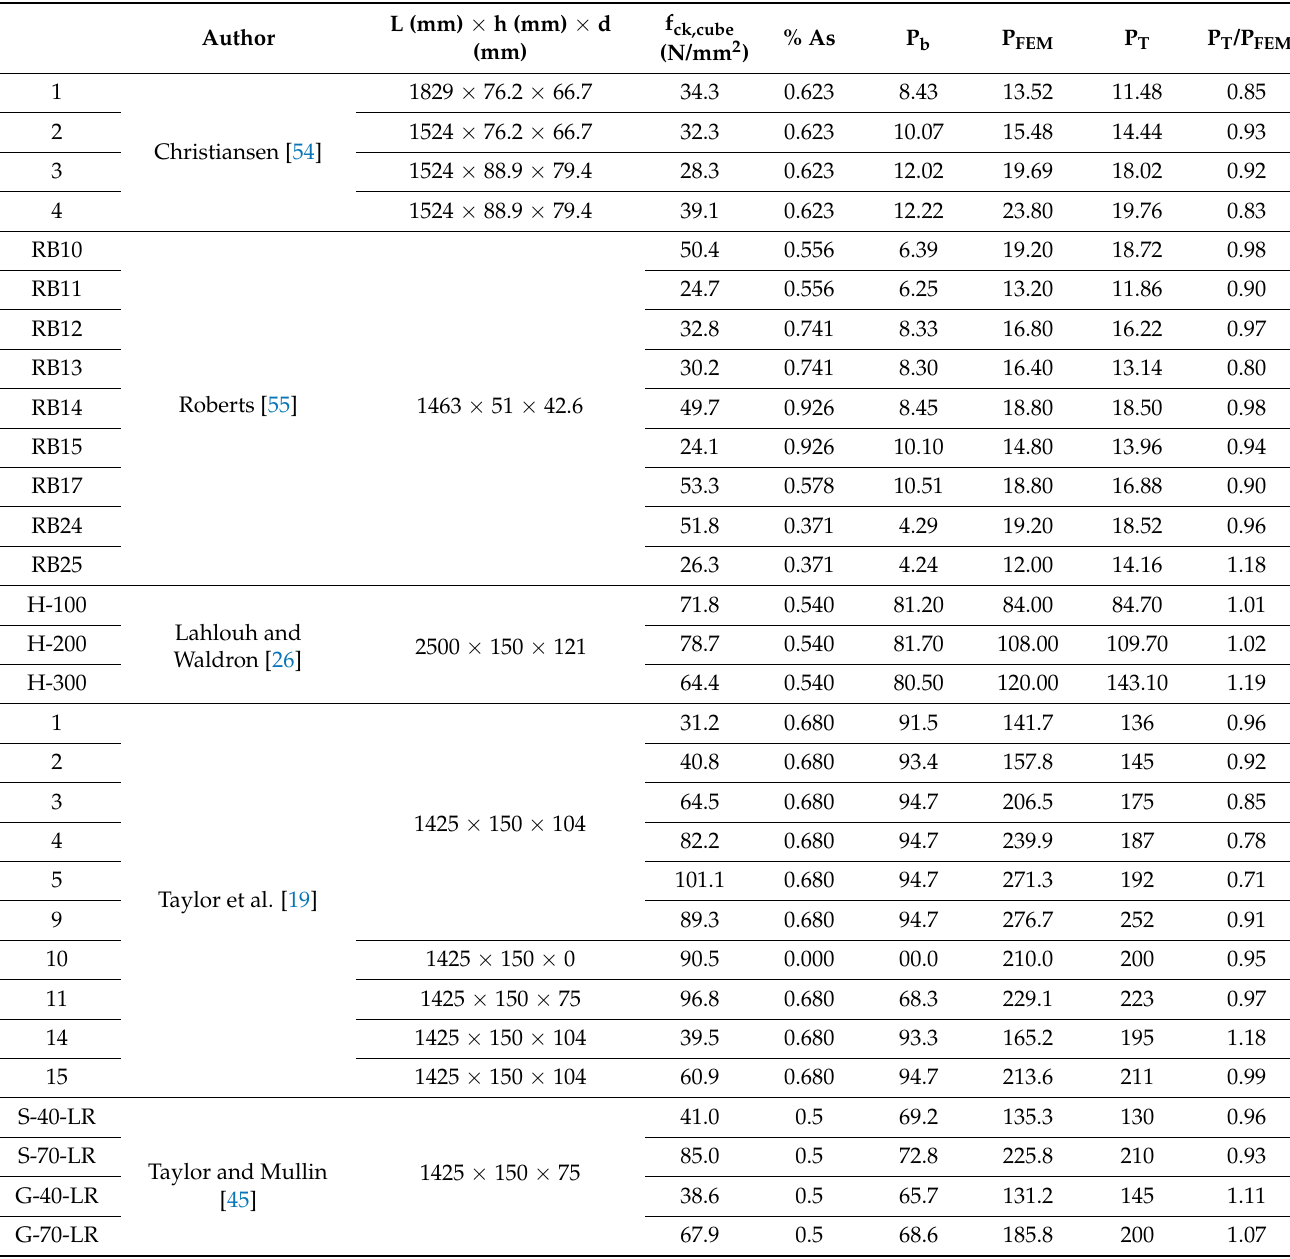
Table 6. Validation of the NLFEA model using data obtained from the